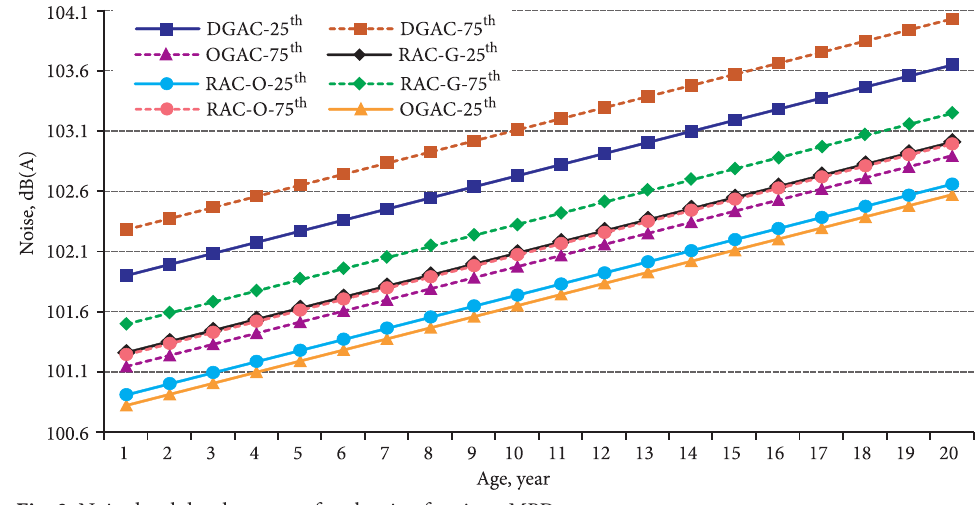
Fig. 2. Noise level development of each mix of various air void content